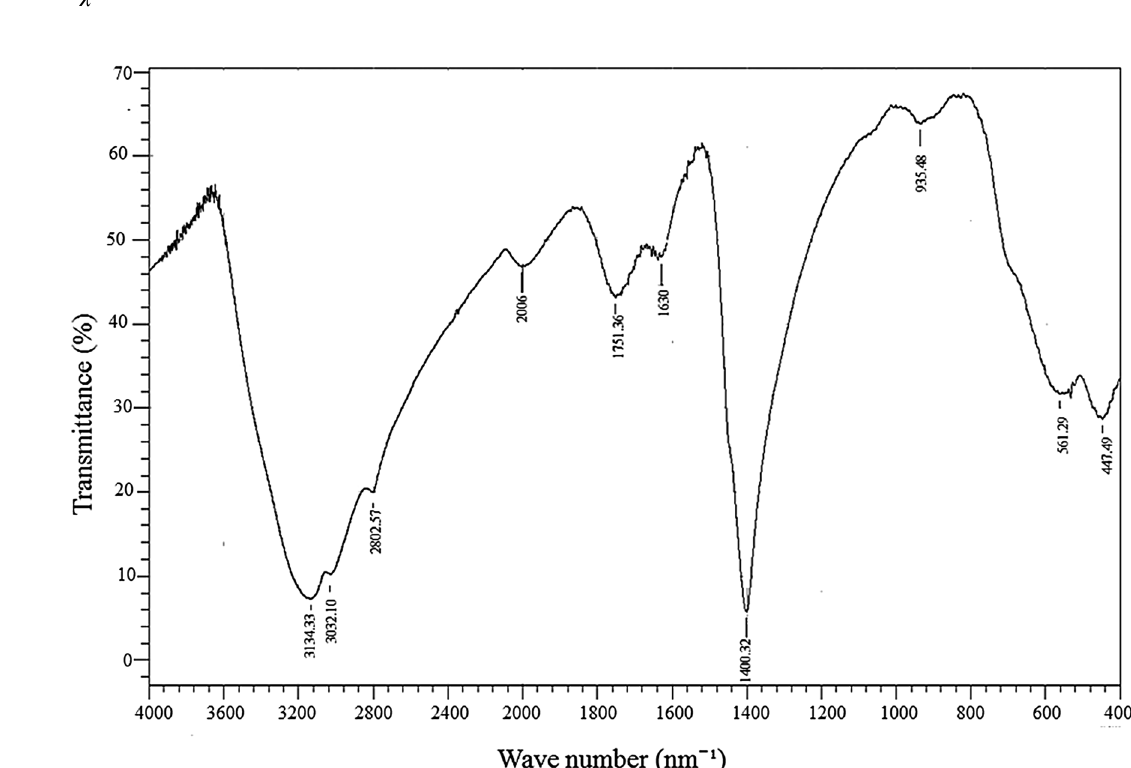
Fig. 3 FTIR spectra of Fe